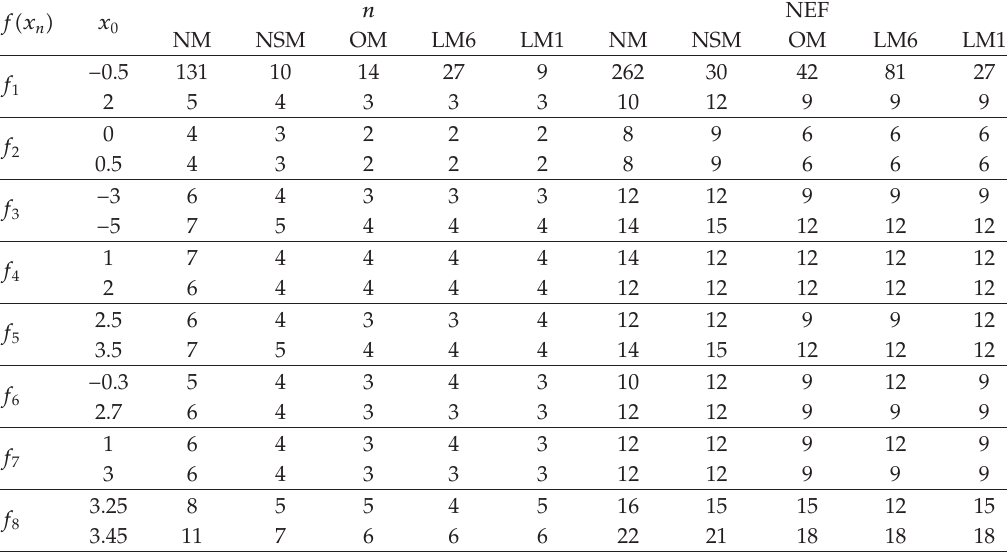
Table 2: Comparison of the methods and Newton’s